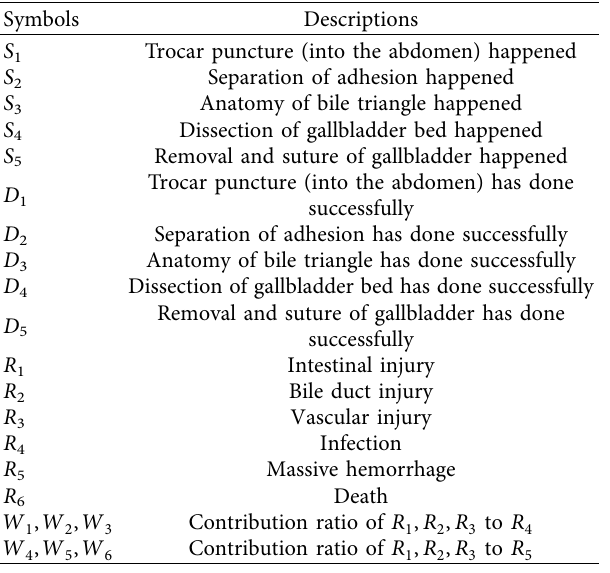
Table 1: List of symbol notations and description.